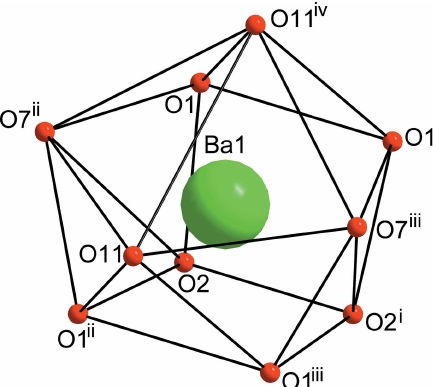
Figure 2 The distorted {BaO 10 } coordination polyhedron in the crystal structure of [Ba(C 6 H 2 N 3 O 7 ) 2 (C 2 H 6 OS)]. Symmetry codes are as in Fig. 1.